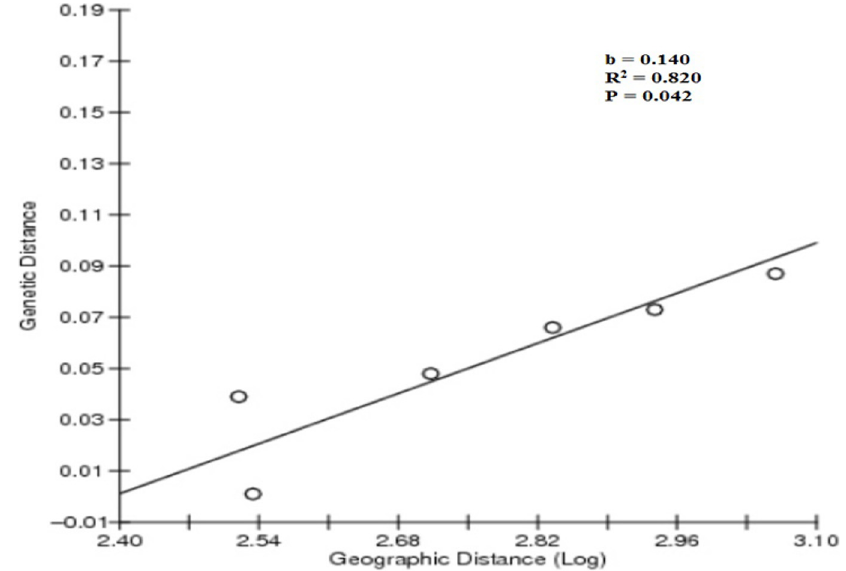
Fig. 3. Pairwise relationship between genetic ( F ST /(1 (cid:2) F ST )) and geographic distance (log( K m )) among populations of Sperata aor